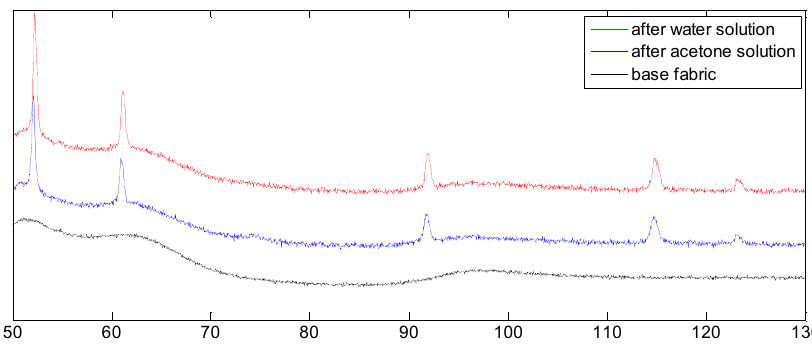
Figure 9. XRD overview scans of the base fabric before and after introduction of Ni particles on a square root intensity scale employing Co radiation. Scans are shifted vertically.